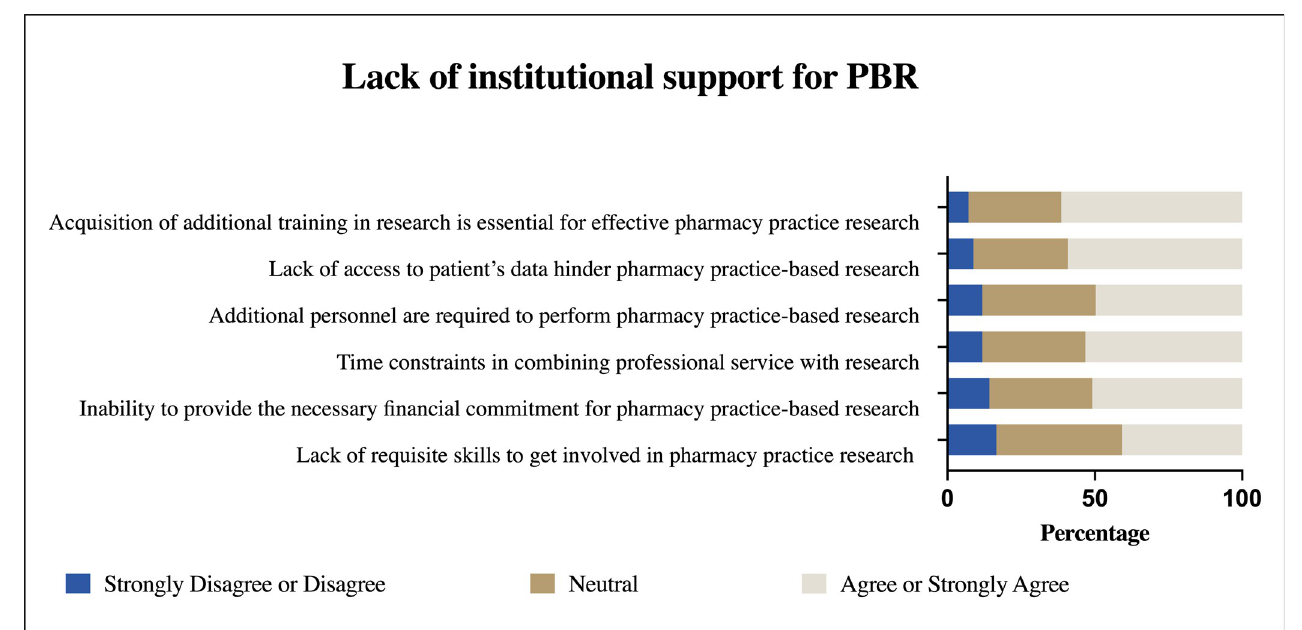
Fig 2. Item analysis of barrier B: Lack of institutional support for (PBR).